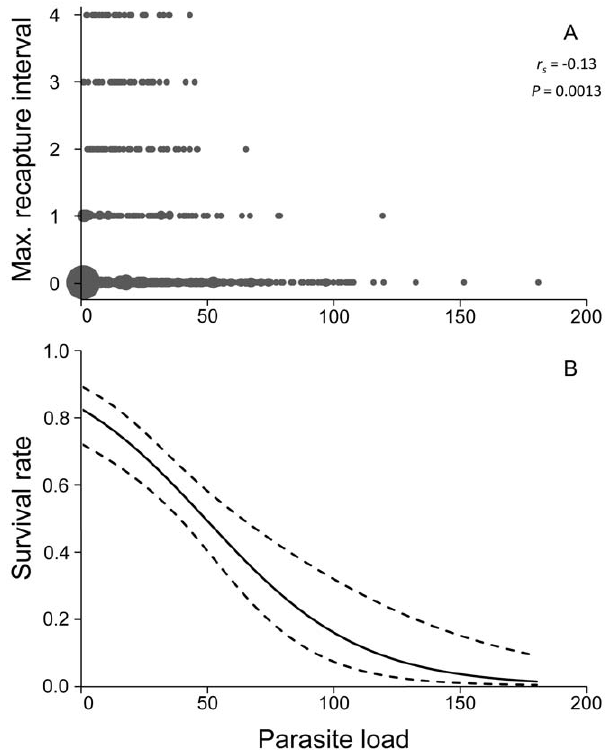
Figure 2. Maximum recapture interval (A) and monthly survival rate (B) of Takydromusviridipunctatus against parasite load. This estimation was derived from 1104 adults during the breeding seasons of 2008 and 2009. The maximum recapture interval (in month) decreased with increasing mean parasite load (the mean number of mites of each capture), where the size of shaded circles is in proportion to the sample size (A). The solid and dashed lines (B) denote estimated survival with the 95% confidence intervals, indicating that monthly survival rate decreased with increasing mean number of mites. The covariate plot is based on model 3 in Table 1 and its maximum likelihood estimates, logit( Q )=1.614 6 0.318 (SE) 2 0.032 6 0.007 6 (mean number of